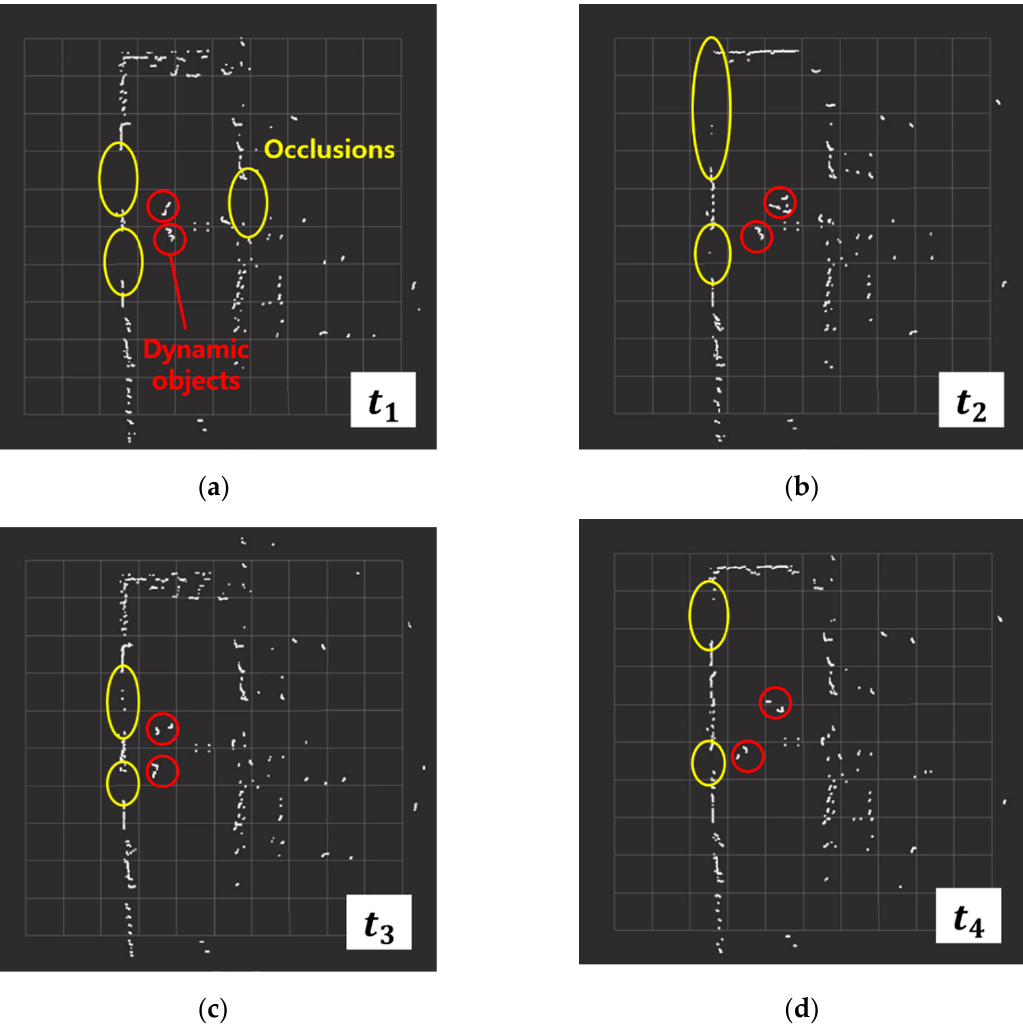
Figure 5. Dynamic objects and scan occlusions in raw scan data. The positions of objects and the occlusions of scans are changed over time. ( a ) t = t 1 ; ( b ) t = t 2 ; ( c ) t = t 3 ; ( d ) t = t 4